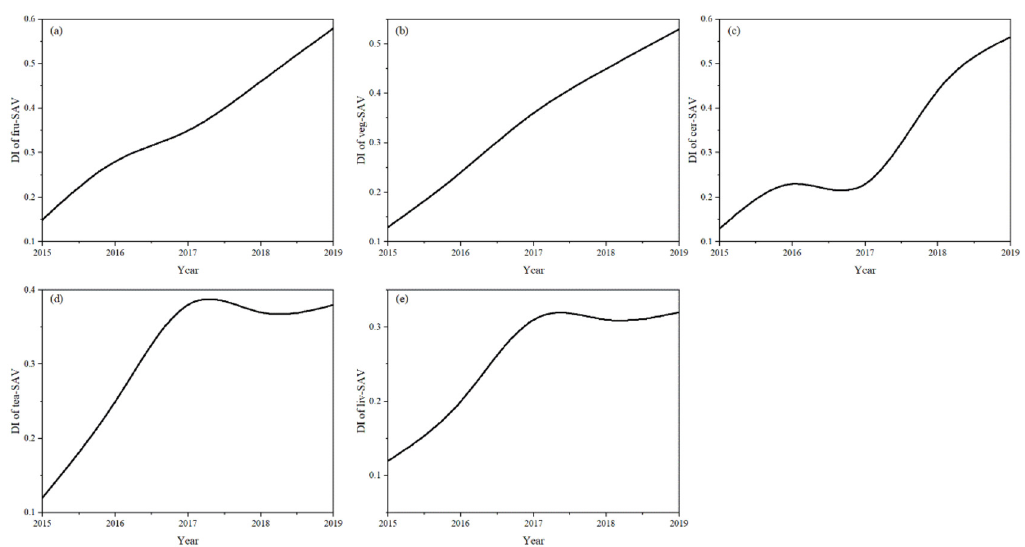
Figure 2. Long-term development indices of fru-SAV ( a ), veg-SAV ( b ), cer-SAV ( c ), tea-SAV ( d ) and liv-SAV ( e ).